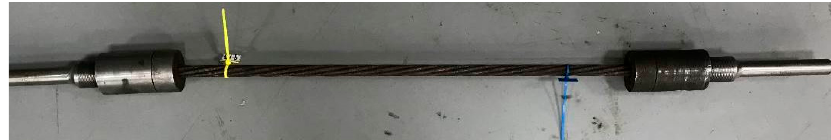
Figure 7. Assembly diagram of steel strand and clamp for fatigue test.